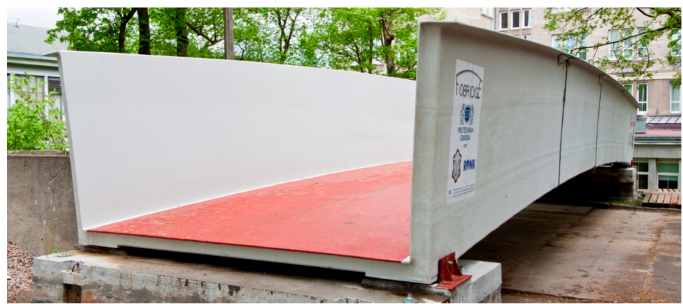
Figure 1. Composite footbridge designed within the FOBRIDGE project.